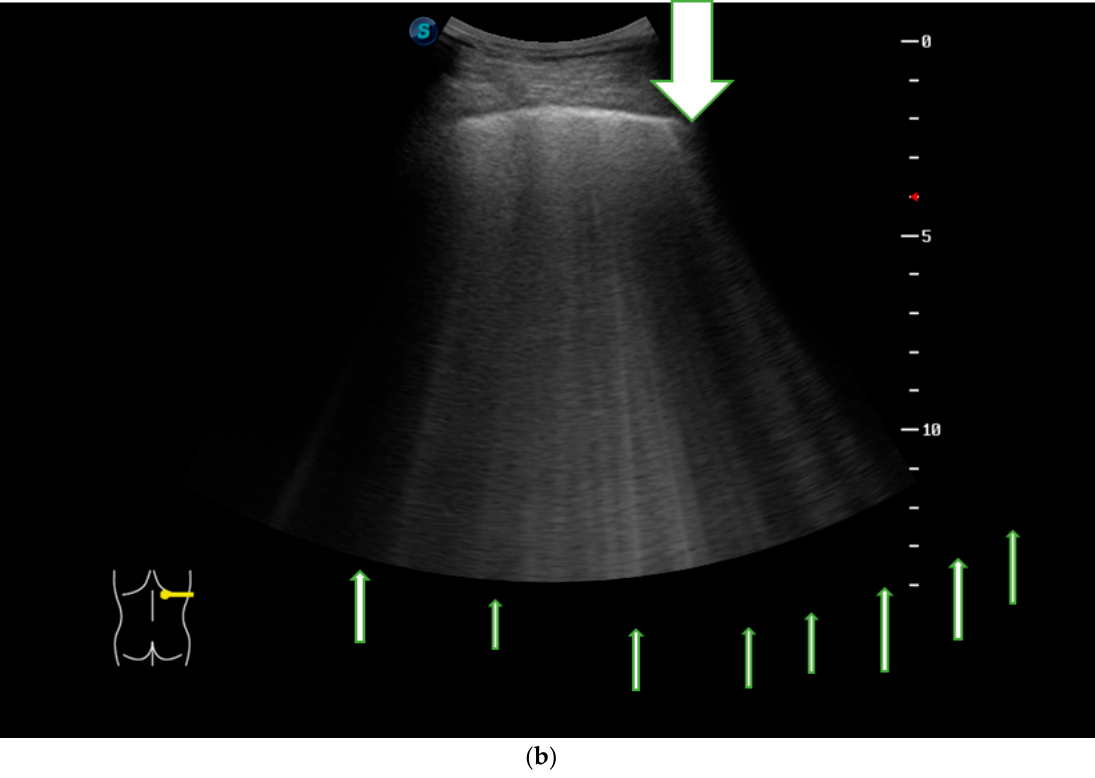
Figure 3. ( a ) HRCT imaging in the lung window at the level of middle and lower lobes with subpleural honey combing and fine reticulation, as well as traction bronchiectasis, that confirm UIP pattern (black lines). ( b ) LUS imaging with multiple B-lines (thin arrow), confirm the fibrotic interstitial syndrome; thick arrow represents pleural line which is not thickened.